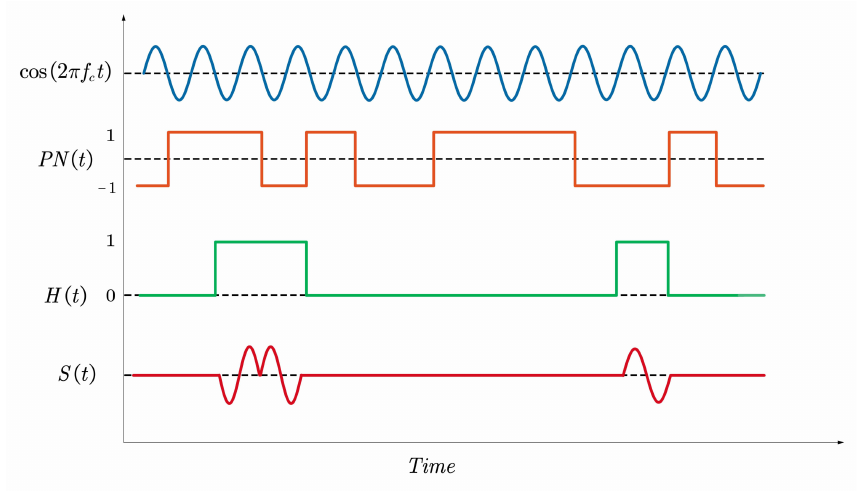
Figure 1. Schematic diagram of PRPS